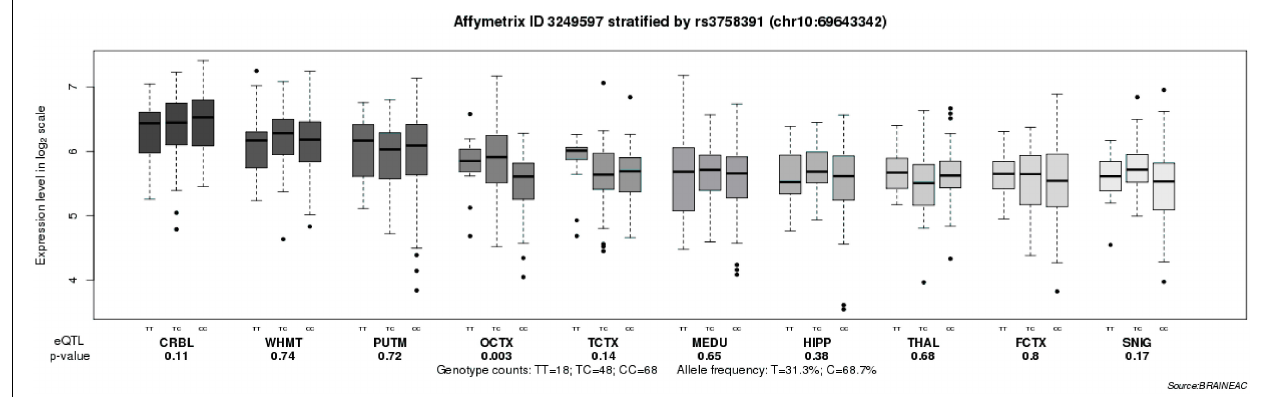
FIGURE 4 | Association of rs3758391 with SIRT1 mRNA expression levels in ten brain regions (Affymetrix ID 3249597; http://peana-od.inf.um.es:8080/ UKBECv12/). SNIG, substantia nigra; PUTM, putamen (at the level of the anterior commissure); MEDU, the inferior olivary nucleus (sub-dissected from the medulla); THAL, thalamus (at the level of the lateral geniculate nucleus); OCTX, occipital cortex; HIPP, hippocampus; FCTX, frontal cortex; TCTX, temporal cortex; WHMT, intralobular white matter; and CRBL, cerebellar